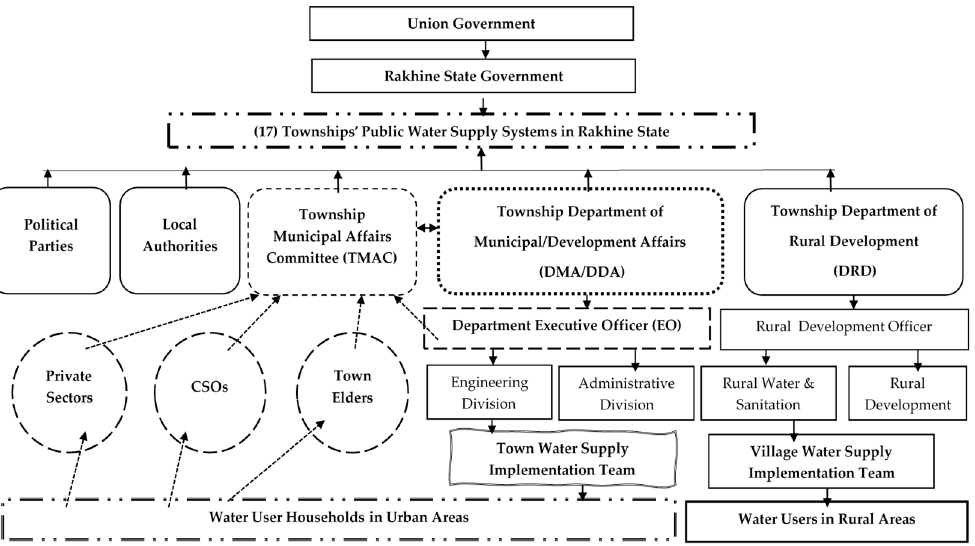
Figure 3. Township-level public water supply governance structure. Source: Rakhine State Depart- ment of Municipal/Development Affairs, 2021.